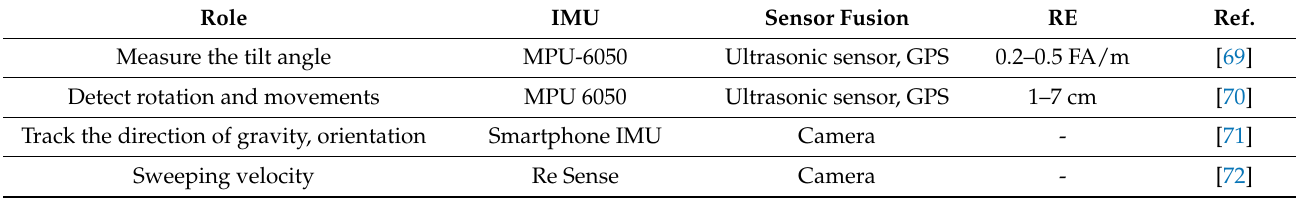
Table 2. Summary of reviewed articles in the gyroscope section.